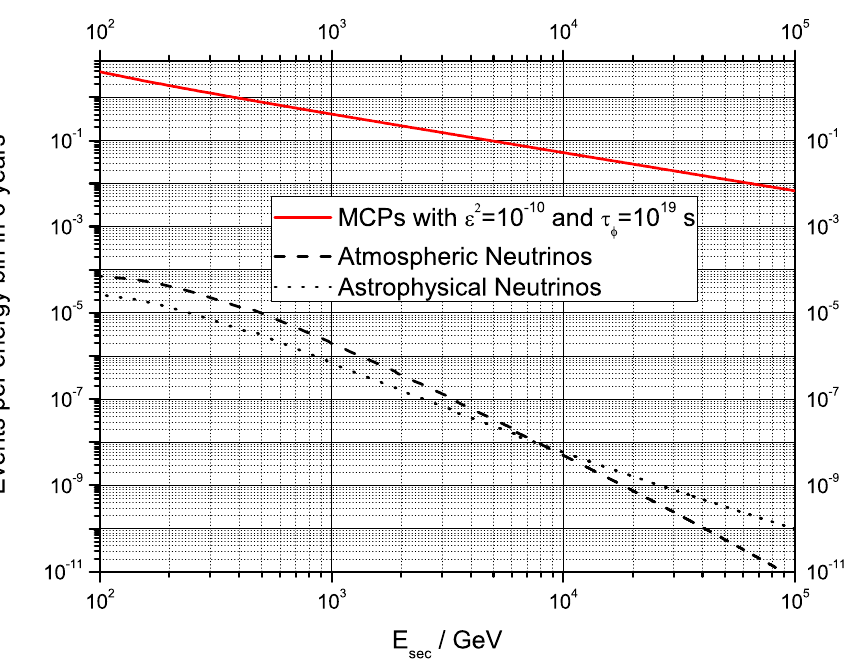
Figure 1 . Distributions of expected MCPs with τ φ = 10 19 s and (cid:15) 2 = 10 − 10 and astrophysical and atmospheric neutrinos. Their energy bins are 100 GeV.